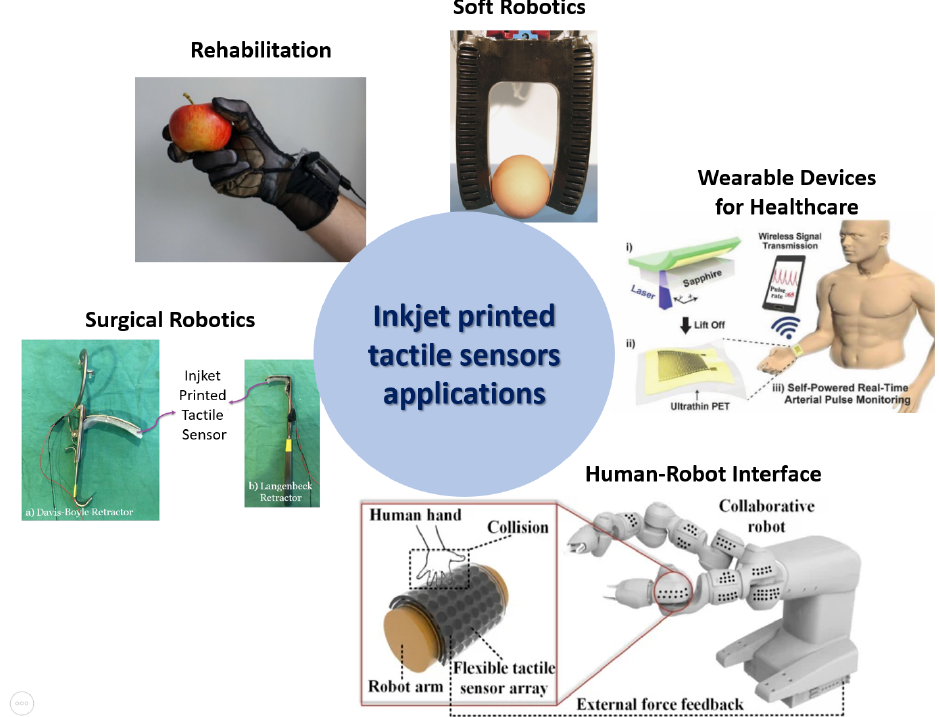
Figure 11. Diagram of inkjet-printed tactile sensor relevant applications: rehabilitation [185], soft robotics [188], wearable devices [192], surgical robotics [132], and human–robot interface